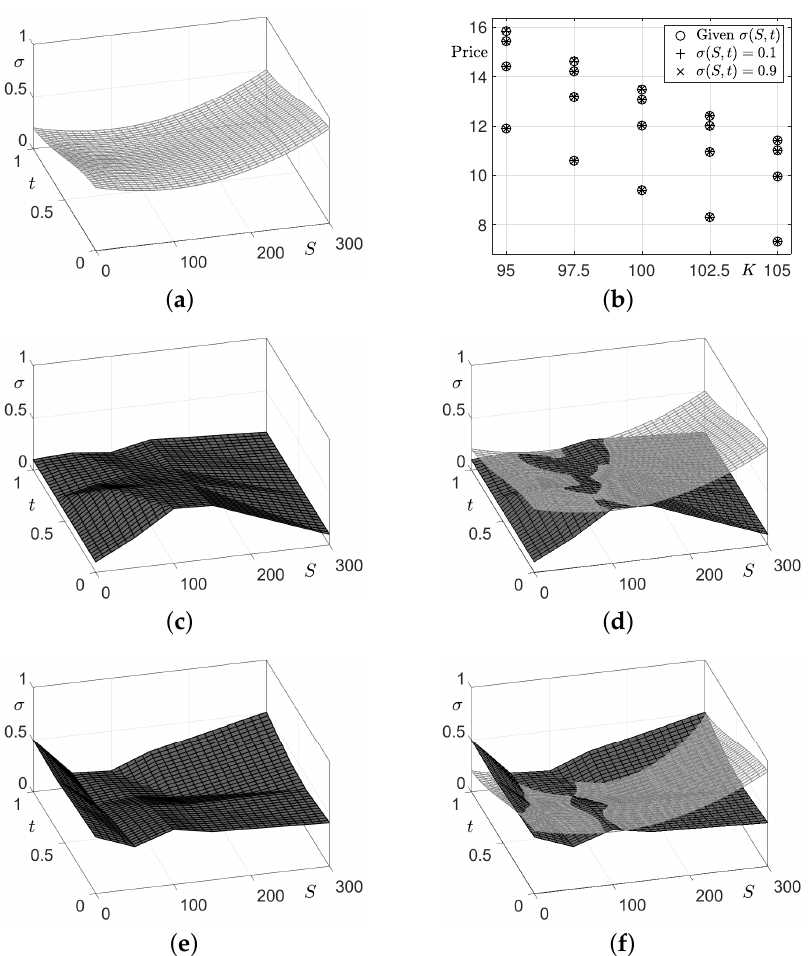
Figure 3. ( a ) Given local volatility function σ ( S , t ) = 0.00001 ( S − S 0 ) 2 + 0.1cos ( π t ) − 0.2 t + 0.4. ( b ) Option prices computed using the given and reconstructed volatility functions. ( c , e ) are recon- structed volatility functions with initial guesses σ ( S , t ) = 0.1 and σ ( S , t ) = 0.9, respectively. ( d , f ) are the overlapped surfaces of ( c ) and ( e ) with ( a ),